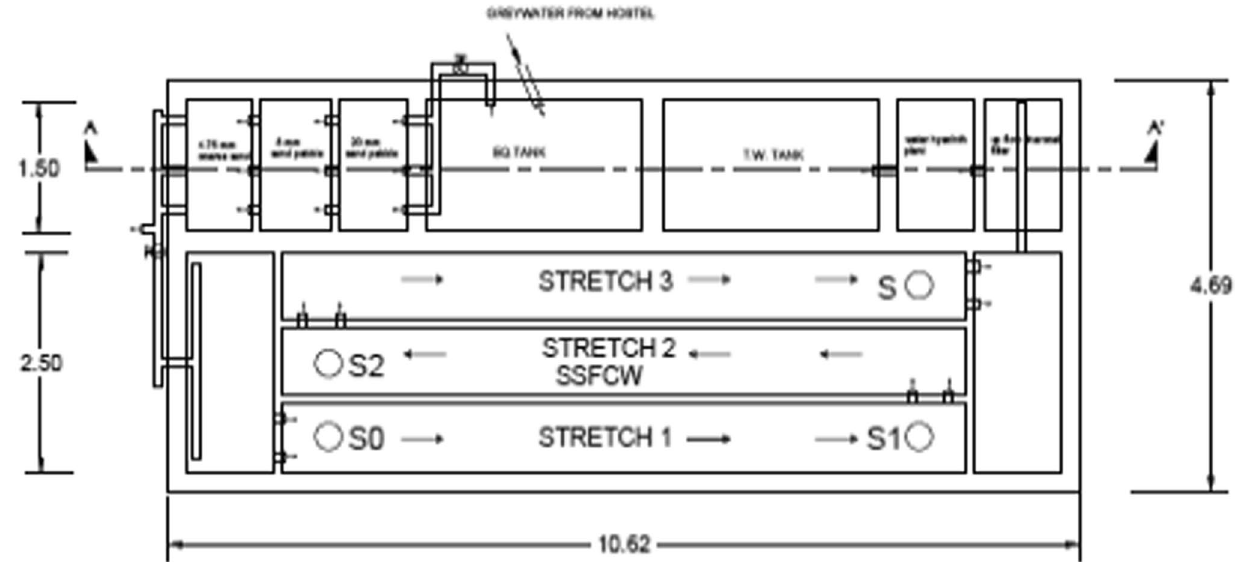
Fig. 1 IOGTS with sampling